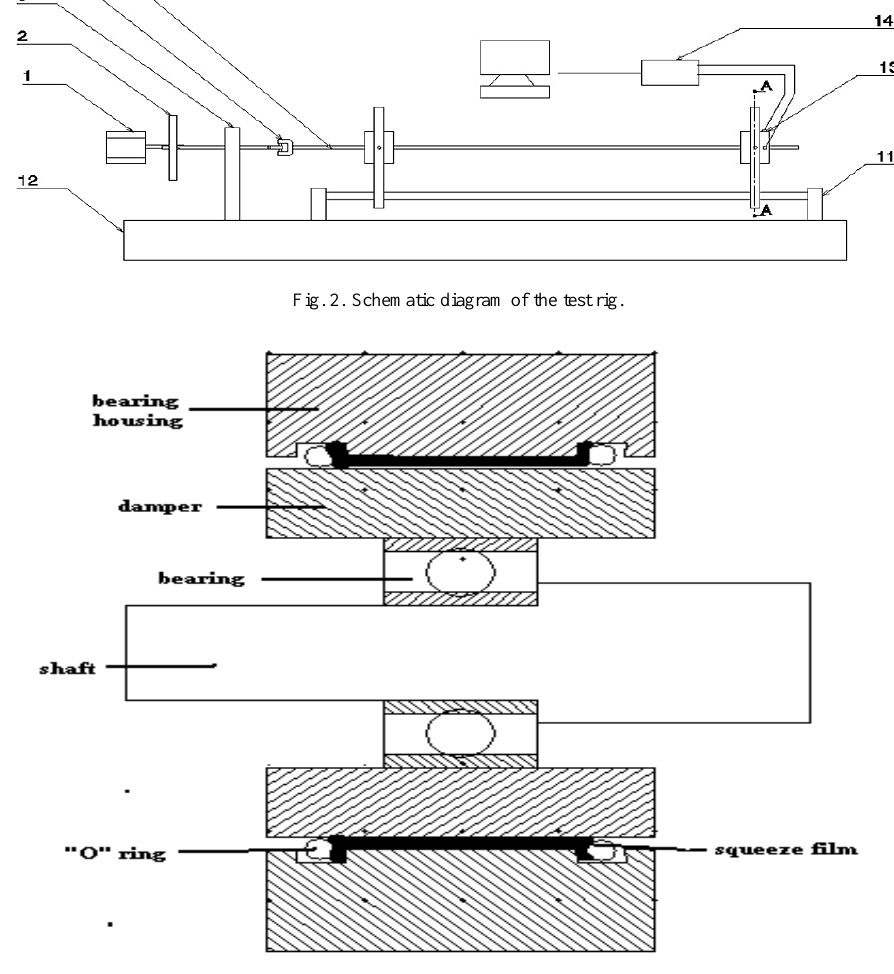
Fig. 3. Schematic diagram of the squeeze film damper